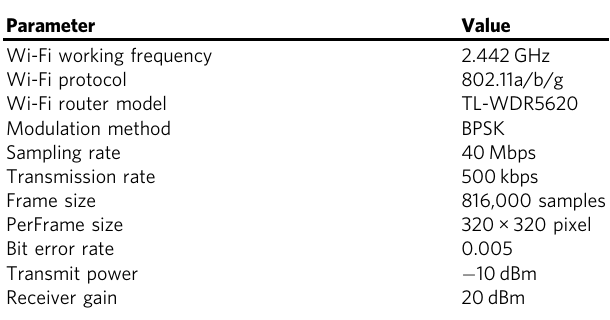
Table 2 Selected key parameters of the designed MBWC demo system based on a software-de fi ned radio (Ettus USRP